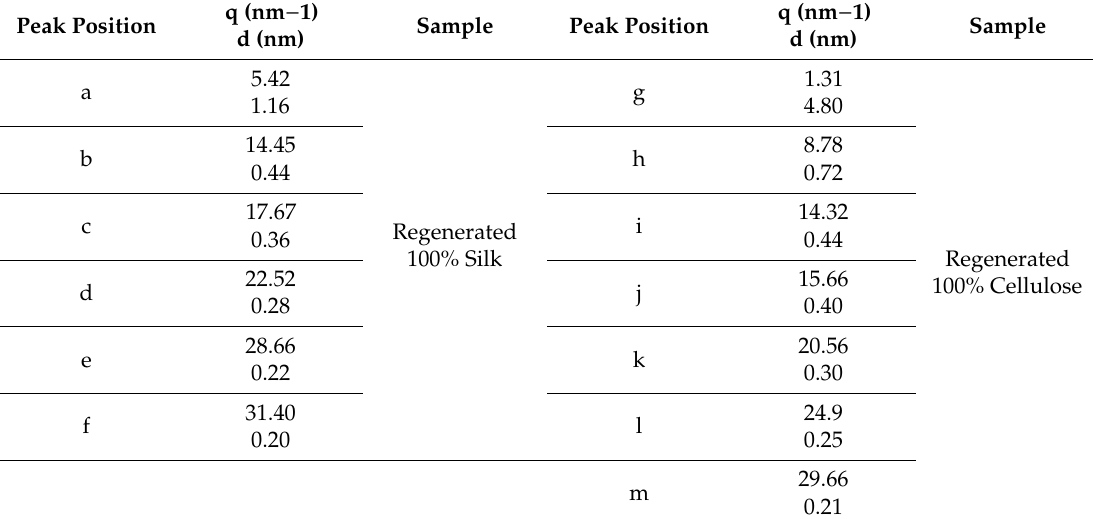
Table 5. Scattering vector and correlation distances for regenerated 100% cellulose and 100% silk samples coagulated with water and ethanol,